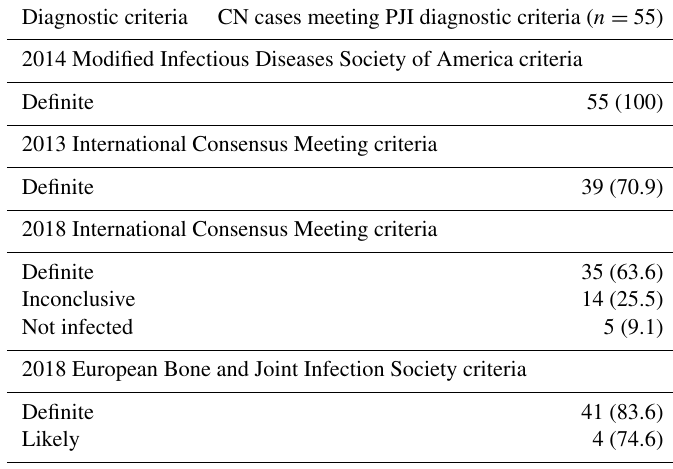
Table 3. Comparison of modified IDSA, EBJIS, and ICM diagnostic criteria with IDSA for CN